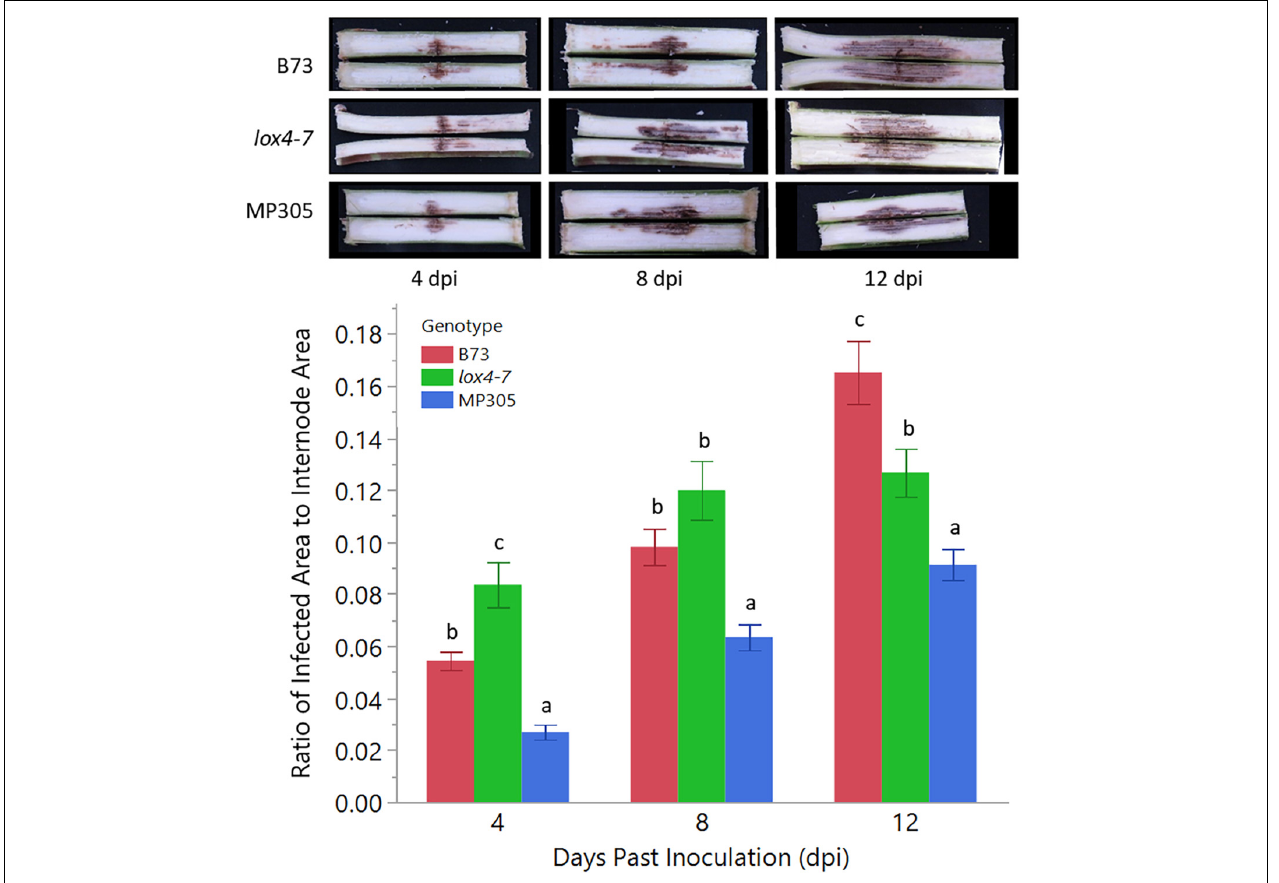
FIGURE 2 | Anthracnose stalk rot (ASR) disease progression in the three genotypes under field conditions. lox4-7 mutant showed a significantly more rapid development of stalk rot at early time points compared to WT B73, although by 12 dpi, WT showed greater disease progression than lox4-7 . MP305 was again significantly resistant at each time point. Bars indicate the average ratios of areas of C. graminicola -infected lesions to surface areas of each respective internode (cm 2 /cm 2 ) in wild type B73 inbred, lox4-7 mutant, and MP305 inbred maize at 4-, 8-, and 12-days post inoculation ( ± SE; different letters indicate significant differences between means within the same time point, determined by Tukey’s HSD, p < 0.05).